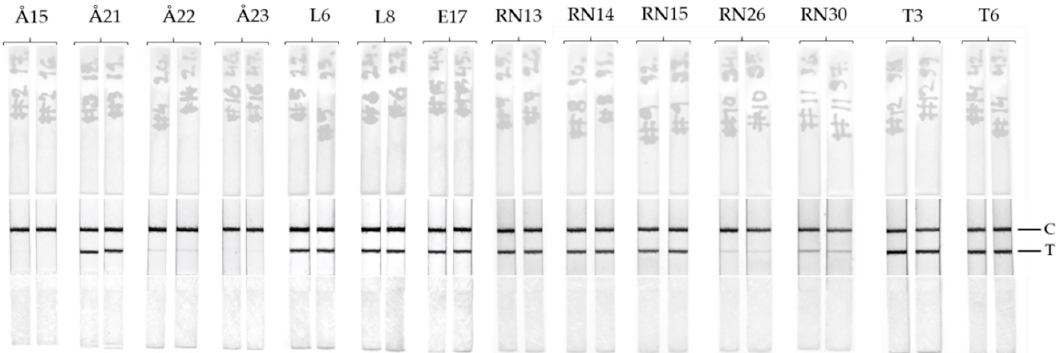
Figure 4. Lateral flow immunoassay with environmental samples. Surface water samples collected from various locations in southwest Finland and Estonia (14) were analyzed with the LFIA. The detailed sample information and analyzed cyanotoxin concentrations with reference methods are presented in Table 1.